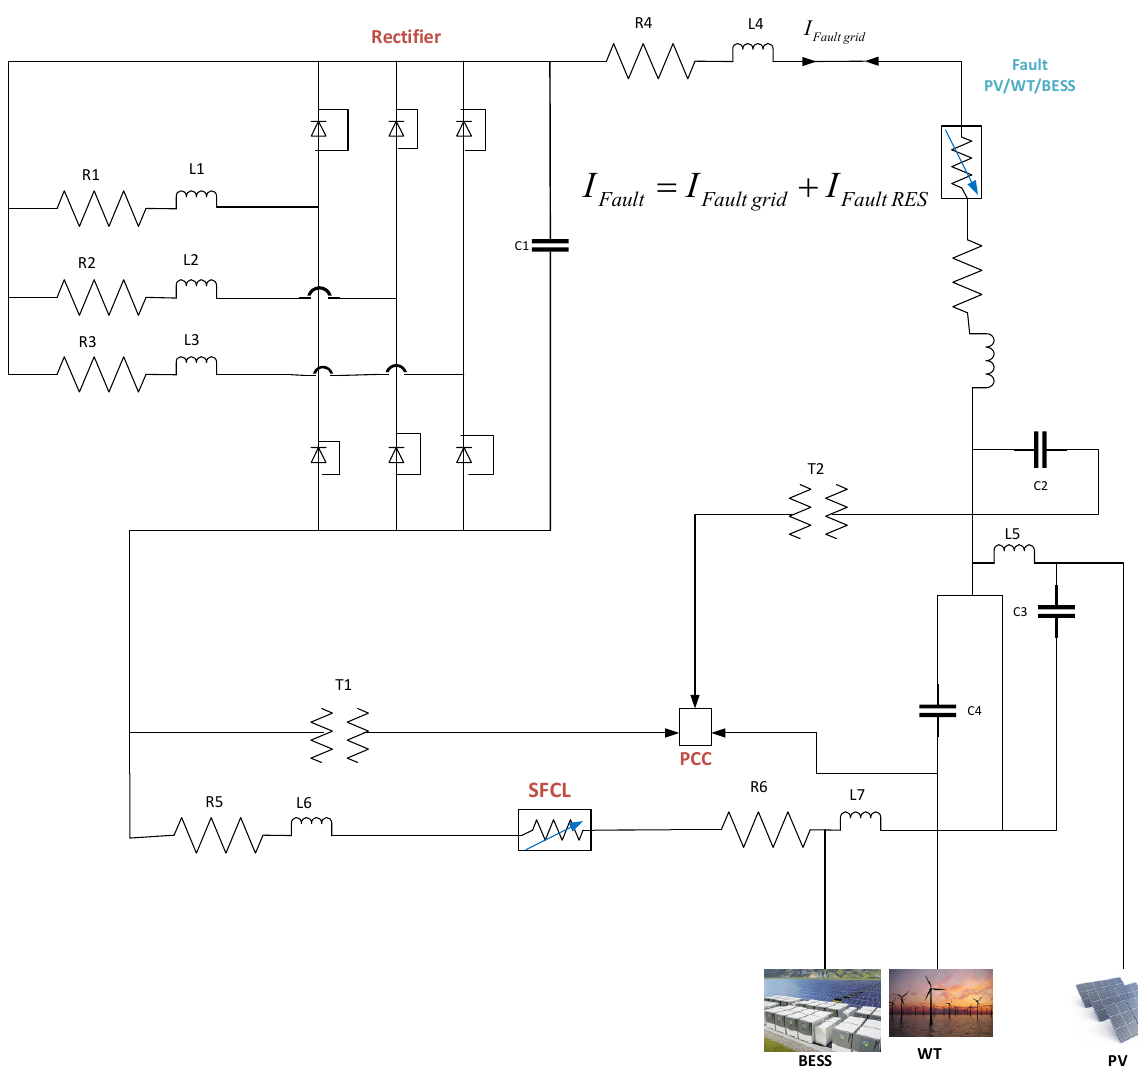
Figure 12. PCC voltage under external fault with SFCL.